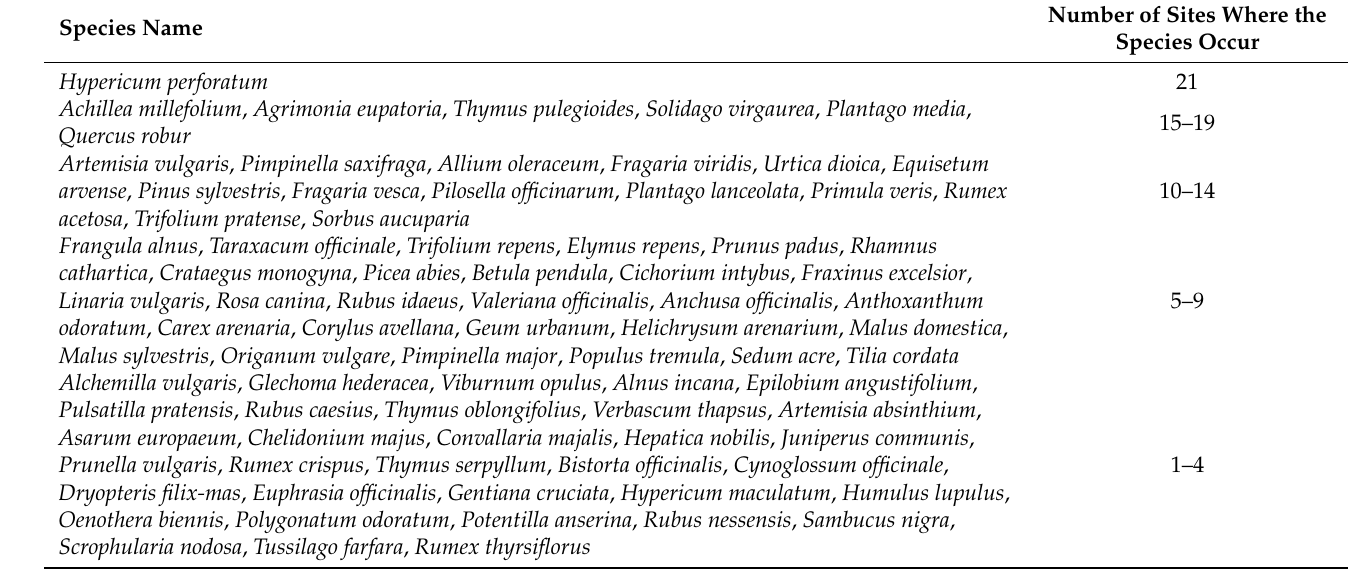
Table 3. Frequency of target-species occurrences across hillfort